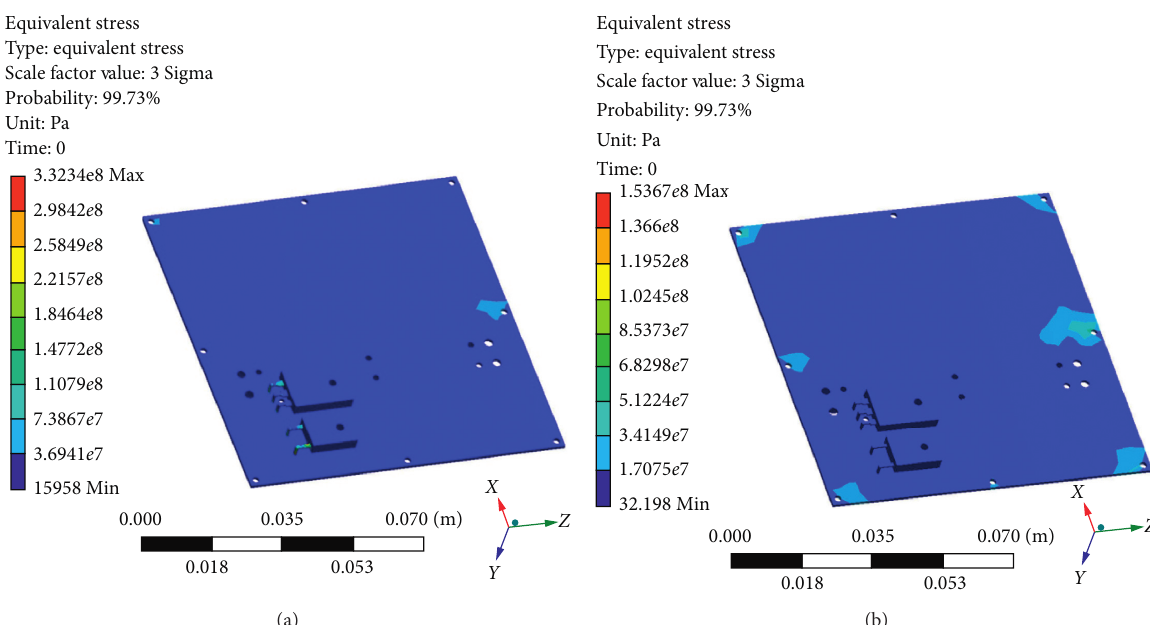
Figure 16: Comparative analysis of semiconductor tube stress simulation: (a) before optimization and (b) after optimization.